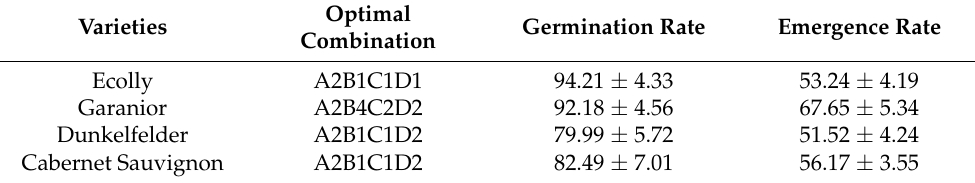
Table 7. Results of repeated